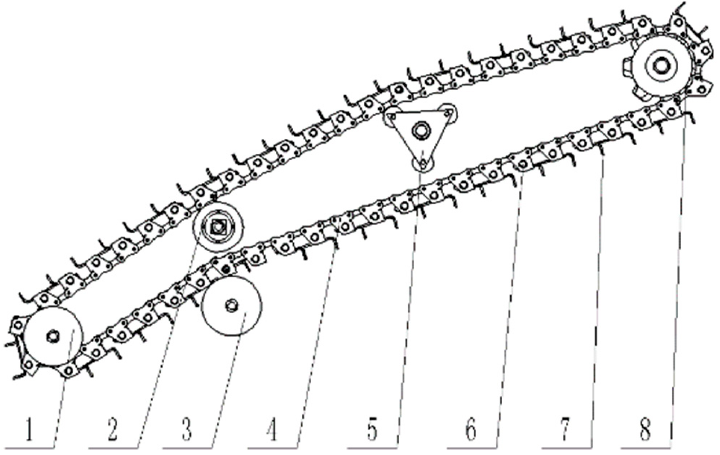
Figure 5. Schematic diagram of the chain drive film soil separation mechanism. 1 driven chain roll- ers; 2 upper rollers; 3 lower rollers; 4 chains; 5 jiggle rollers; 6 chain rods; 7 pop-up teeth, and 8 active chain rollers.